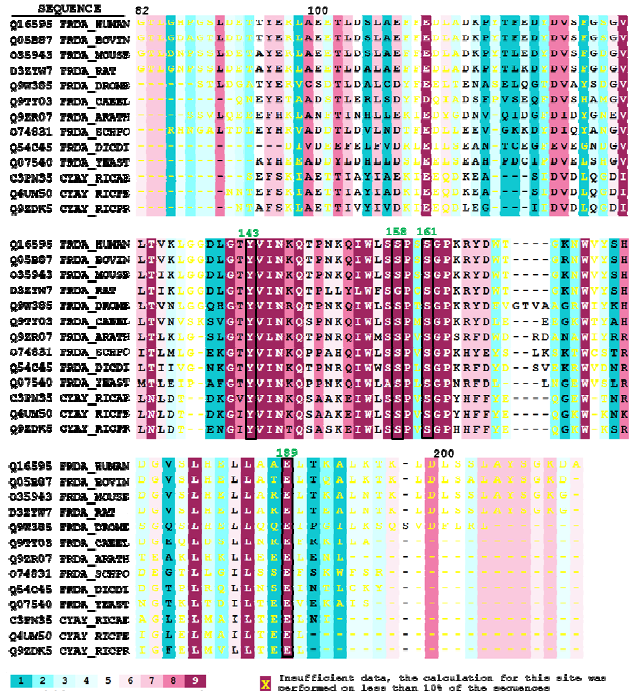
Figure 2. Multiple sequence alignment of Frataxin sequences used in ConSurfID35 analysis. Residues are colored according to the conservation scores calculated by ConSurf. The input pdb se- quence corresponds to the sequence of human mature frataxin extracted from pdb entry 3S4M. Residues from conservation cluster 3 are boxed, and its position in the human frataxin sequence indicated in green numbers. Uniprot codes and entry names are indicated for each sequence. This alignment is also color-coded by conservation scores and shows that most conserved residues are found in the central part of the sequence, which corresponds to the beta sheet of the protein. These highly conserved residues could be grouped in four different conservation clusters according to their spatial disposition. The four conserva-